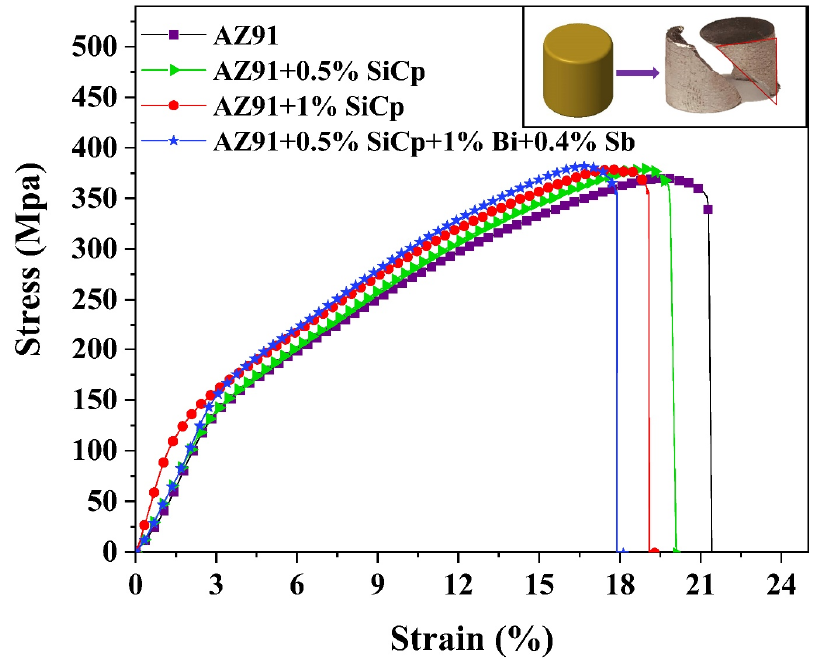
Figure 5. Engineering compressive stress–strain curves of pure AZ91 and AZ91 composites with different hybrid nano- and micro-reinforcements. Table 5. Compression strength comparison of pure AZ91 and AZ91 composites with different hybrid nano- and micro-